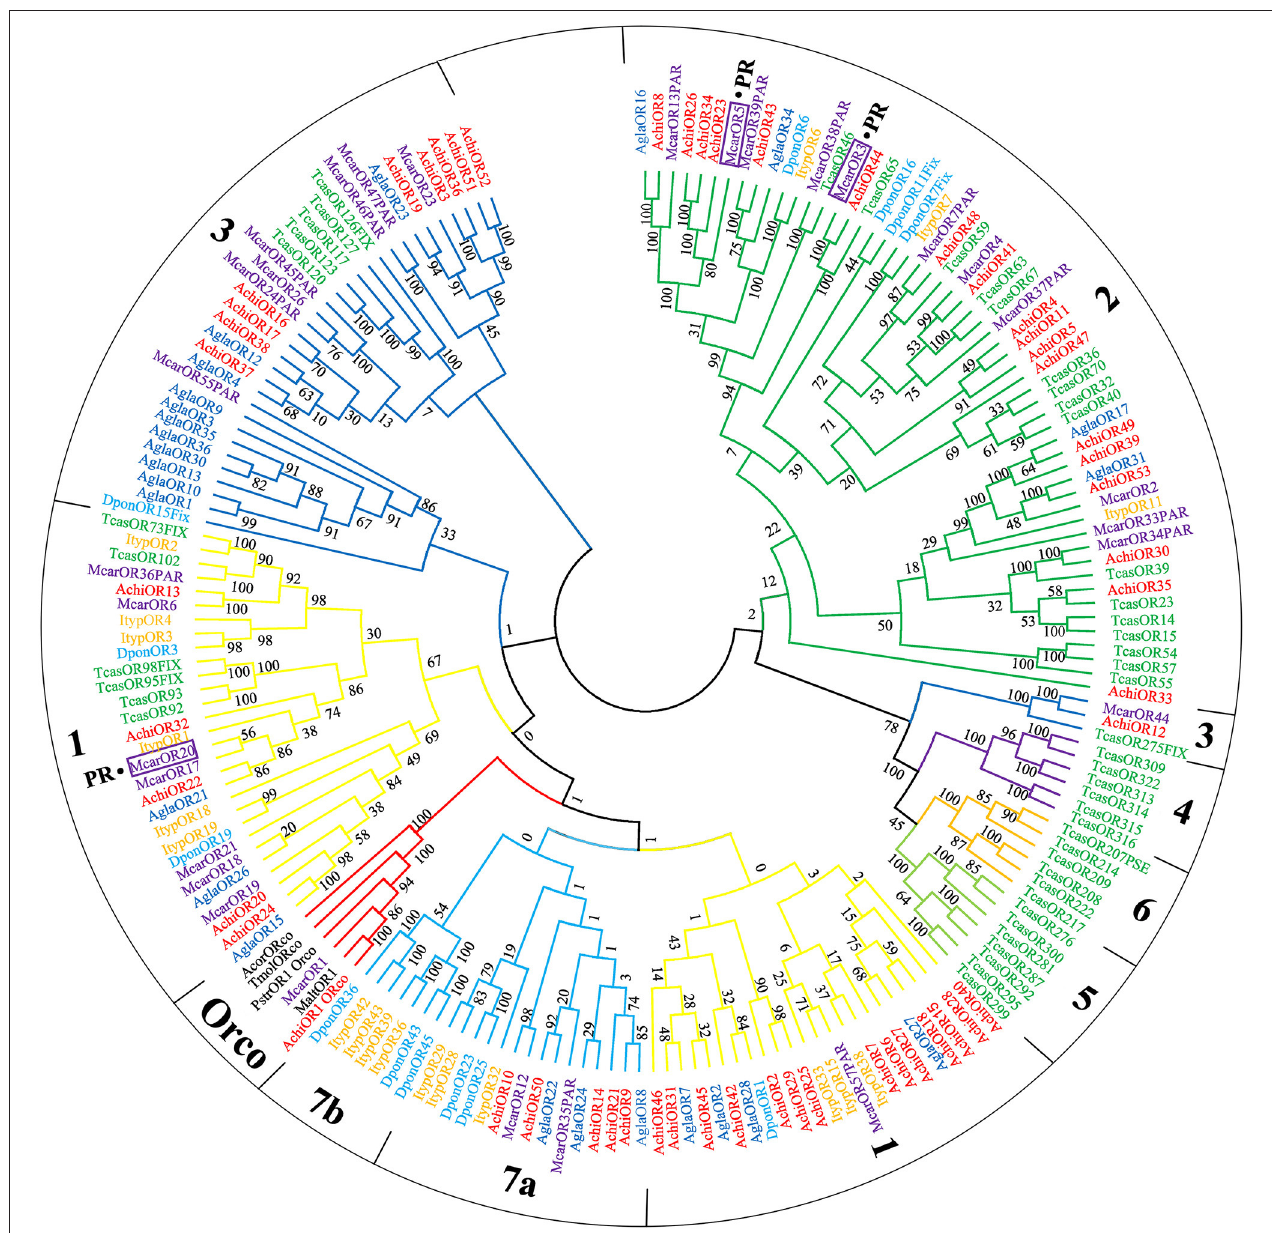
FIGURE 2 | Phylogenetic tree of putative odorant receptor (OR) genes. The tree was constructed using MEGA6 with Neighbor-joining method. Achi: A. chinensis ; Tcas: T. castaneum ; Agla: A. glabripennis ; Dpon: D. ponderosae ; Ityp: I. typographus ; Pstr: P. striolata ; Acor: A. corpulenta ; Malt: M. alternates ; Tmol: T. molitor